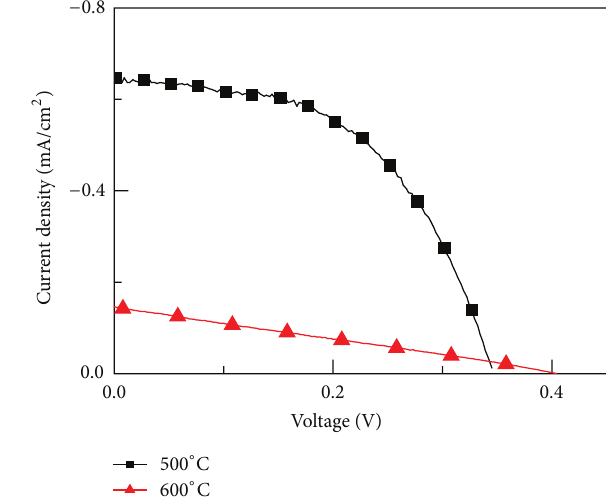
Figure 5: J-V characteristics of DSSCs sensitized with extracts of Tradescantia Zebrina based on TiO 2 nanotube arrays annealed at different